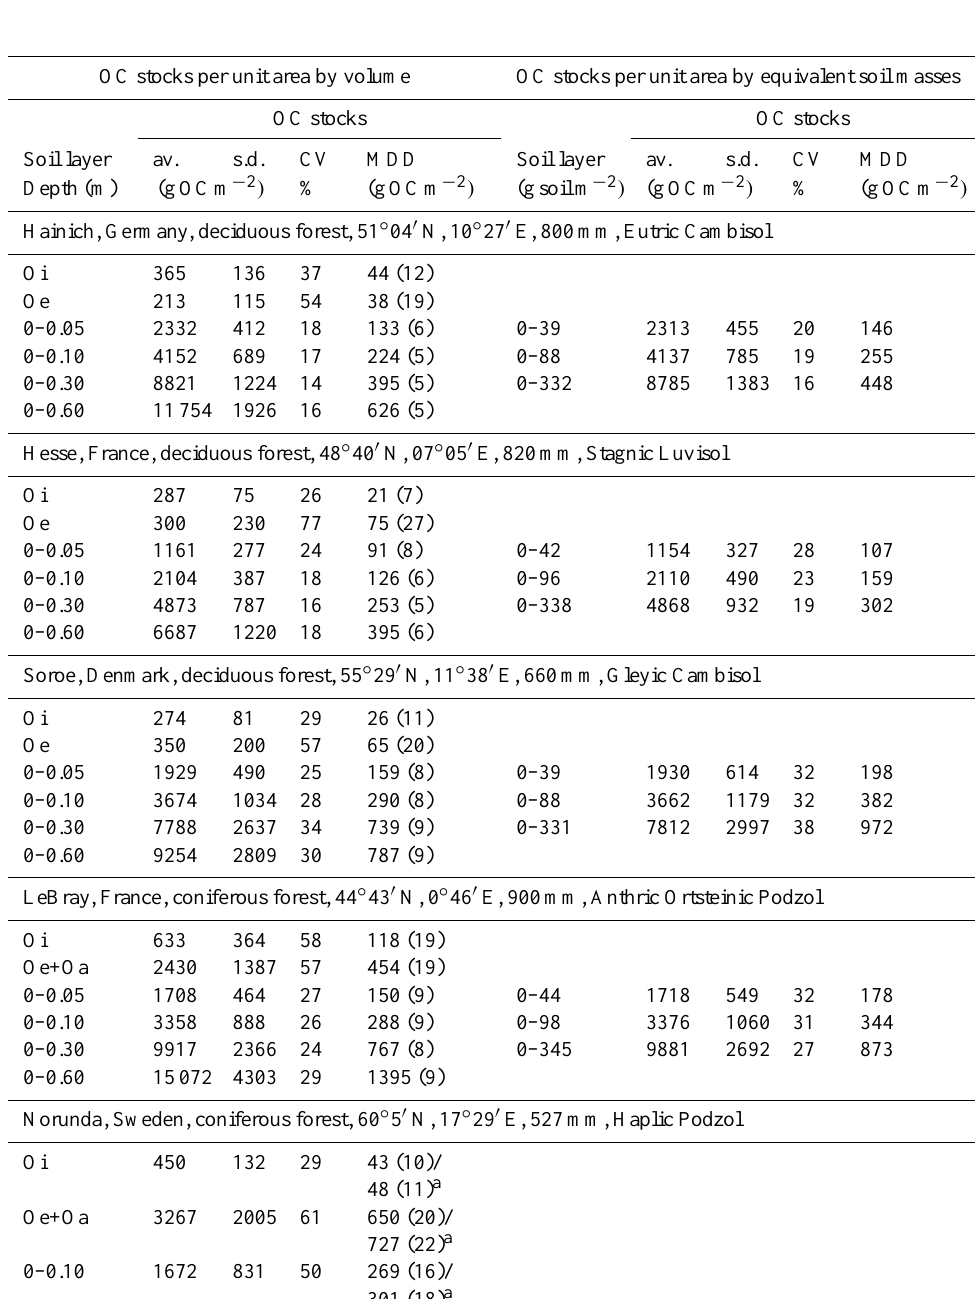
Table 2. Average OC stocks (av.) for different soil layers, their standard deviation (s.d.), coefficient of variation (CV), and minimum to definite soil volumes, as the soil samples were taken by depth increments. Values to the right were calculated for definite soil masses (average soil mass of each site and layer) per unit